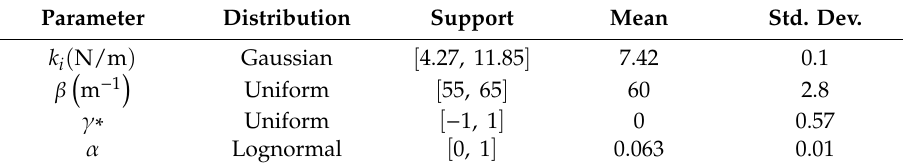
Table 2. Uncertain parameters of the BWBN benchmark model.